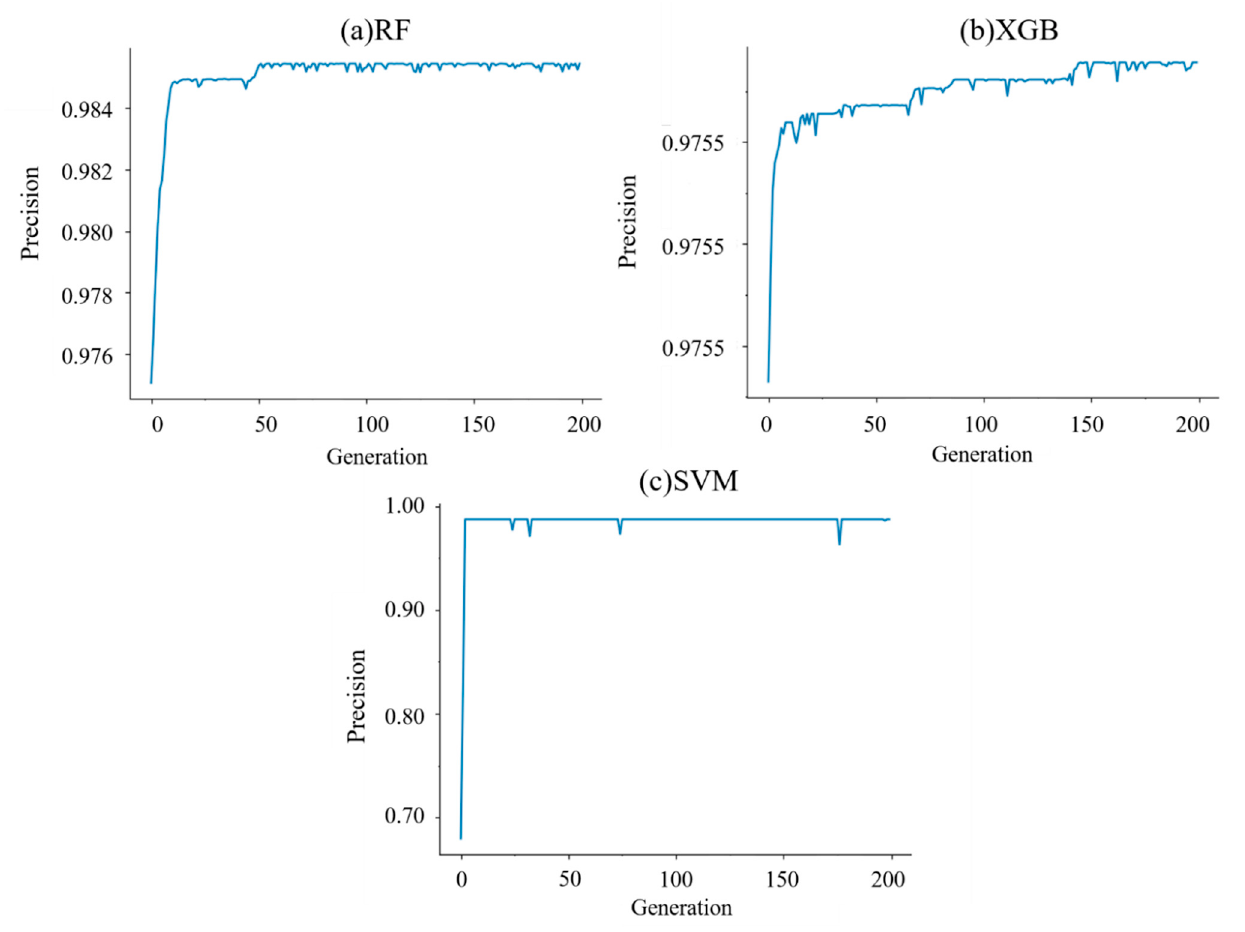
Figure 4. Model precision versus generation ( a ) RF, ( b ) XGB, ( c ) SVM. Table 3. Default and optimized hyper-parameter values using a genetic algorithm and grid search method.